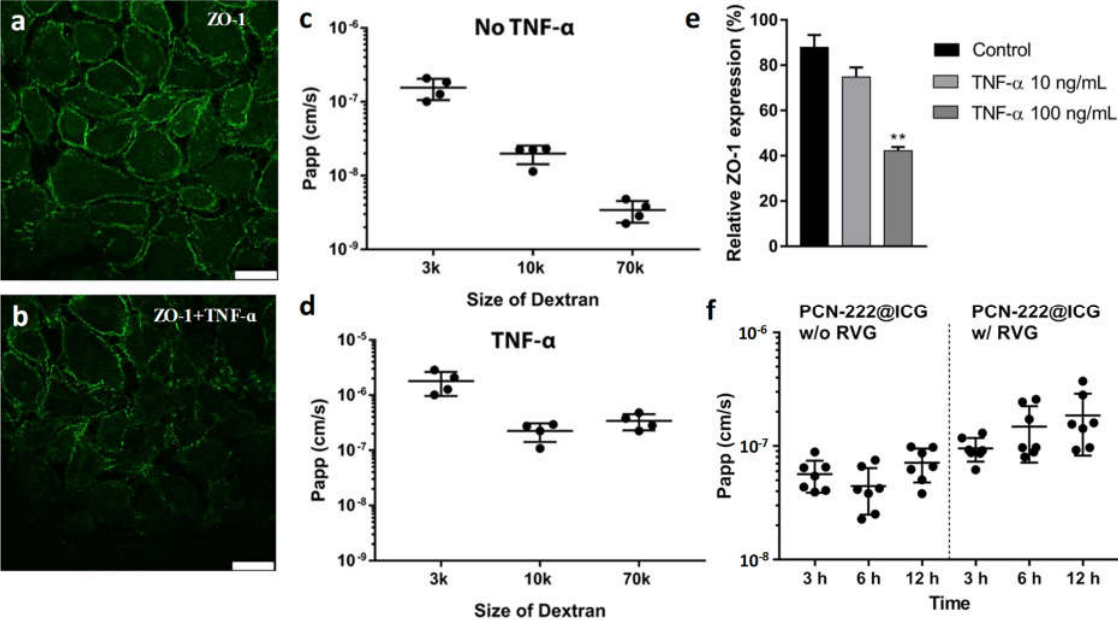
Figure 8. HUVEC cell−cell junctions stained for ZO−1 ( a ) without treatment and ( b ) treated with 100 ng mL −1 of TNF−α. Scare bar: 25 µm. ( c ) Permeability of FITC −dextran tracers of various sizes (3, 10, or 70 kDa) in the BBB chips ( c ) without treatment and ( d ) treated with 100 ng mL −1 of TNF−α. ( e ) Relative endothelium ZO−1 expression change with various concentrations of TNF−α treatment ** p < 0.01; one-way ANOVA with Dunnett’s multiple comparisons test, n = 6). ( f ) Permeability of PCN−222@ICG without and with conjugation of RVG at 3 h, 6 h, and 12 h.